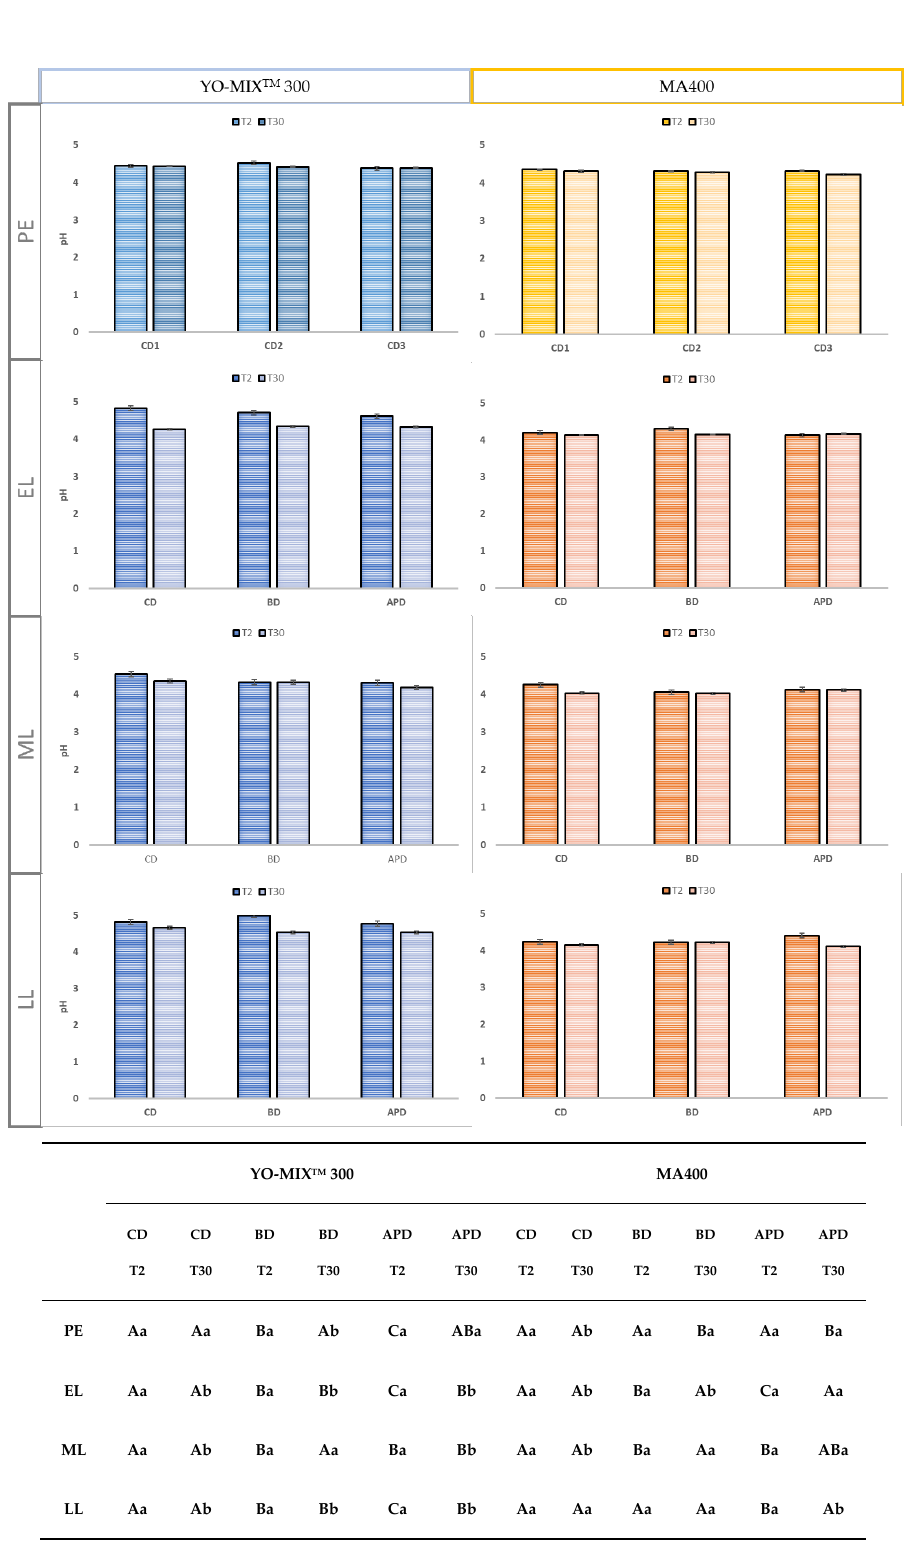
Figure 2. pH value of fermented milk during refrigerated 2 and 30 days at 4 °C using a thermophilic starter culture (YO-MIX TM 300) and mesophilic starter culture (MA400). PE: Pre-experimental; EL: Early lactation; ML: Middle lactation; LL: Late lactation; CD: Control diet; BD: Broccoli by-products diet; APD: Artichoke plant by-products diet. The lowercase letters refer to the differences between days (T2 and T30) of the same type of diet in each of the rows (production); Capital letters refer to the differences between diets at each of the times for each of the rows